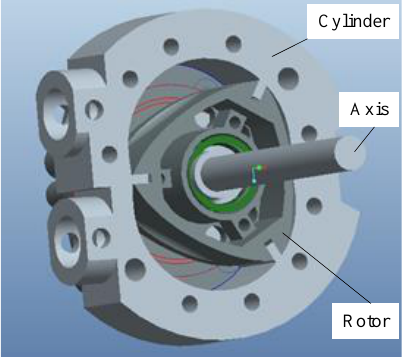
Figure 1. The structure of the Wankel engine.